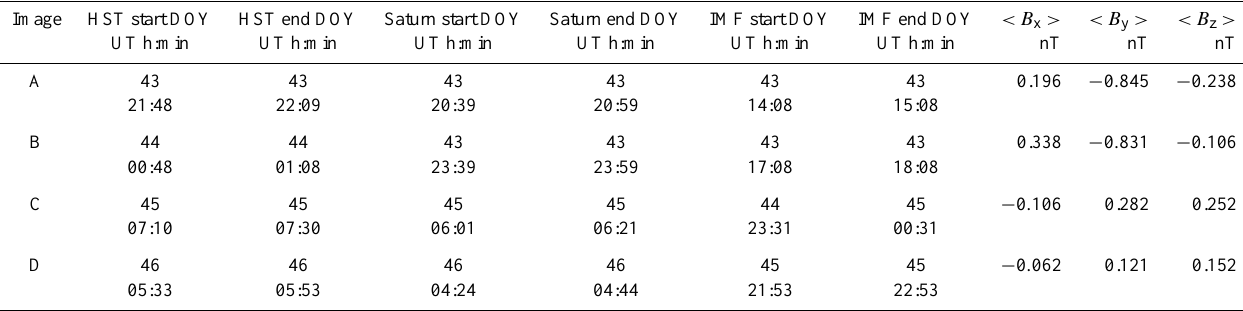
Table 1. For each HST image we give from left to right the start and the end times of the HST imaging interval (DOY/UT h:min), the start and end times of the light emission at Saturn, the lagged IMF times as discussed in the text, and the corresponding 1h averaged KSM IMF components